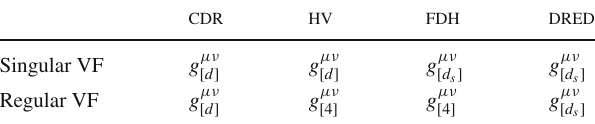
Table 1 Treatment of vector fields in the four different regularization schemes, i.e. prescription which metric tensor has to be used in prop- agator numerators and polarization sums. The quantity d s is usually taken to be 4. This table is taken from Ref. [6]